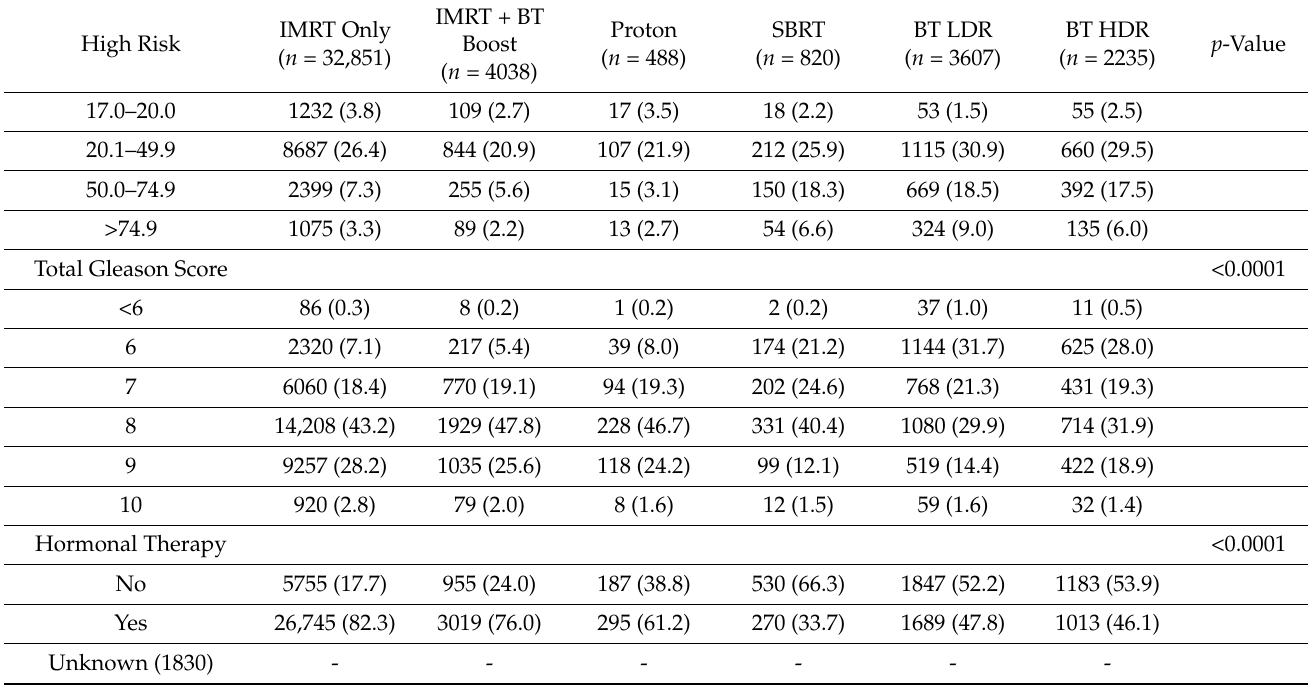
Figure 6. Kaplan–Meier curve for cumulative survival of intermediate-risk patient prostate cancer (PCa) patients treated with the compared modalities.